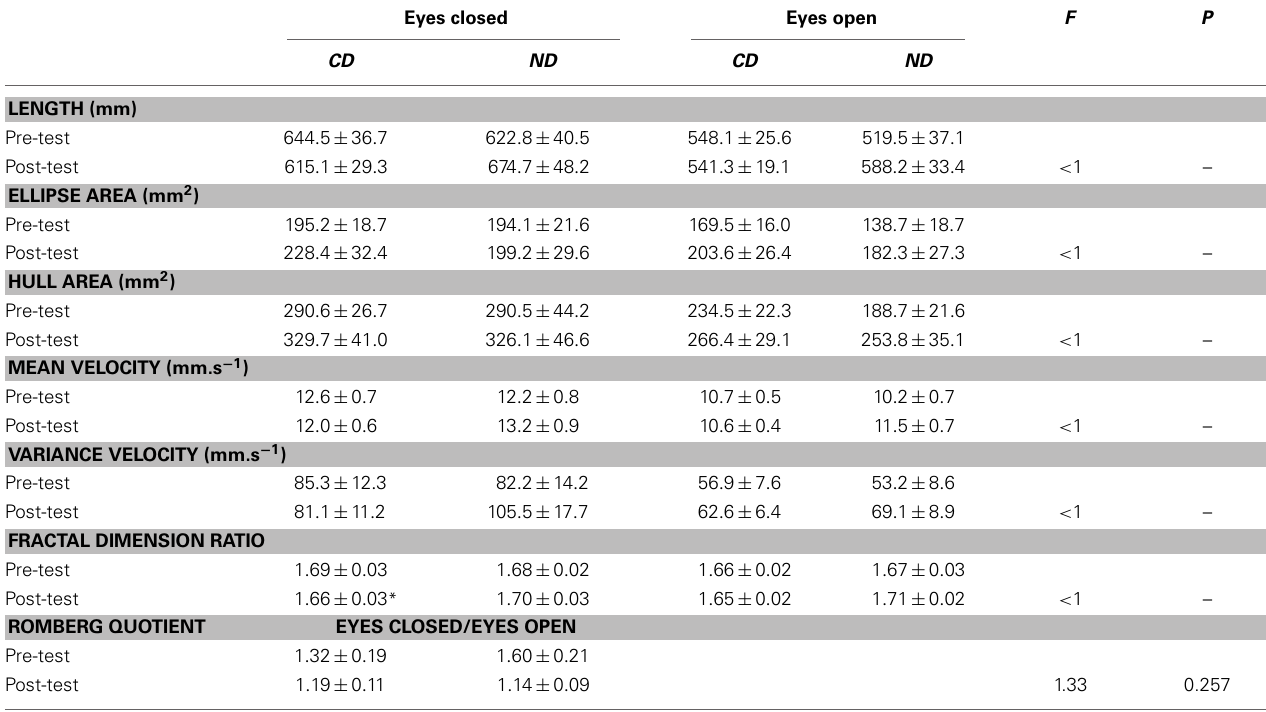
Table 2 | Mean ± SE of statistic scores for the groups of participants (CD, contemporary dance; ND, no